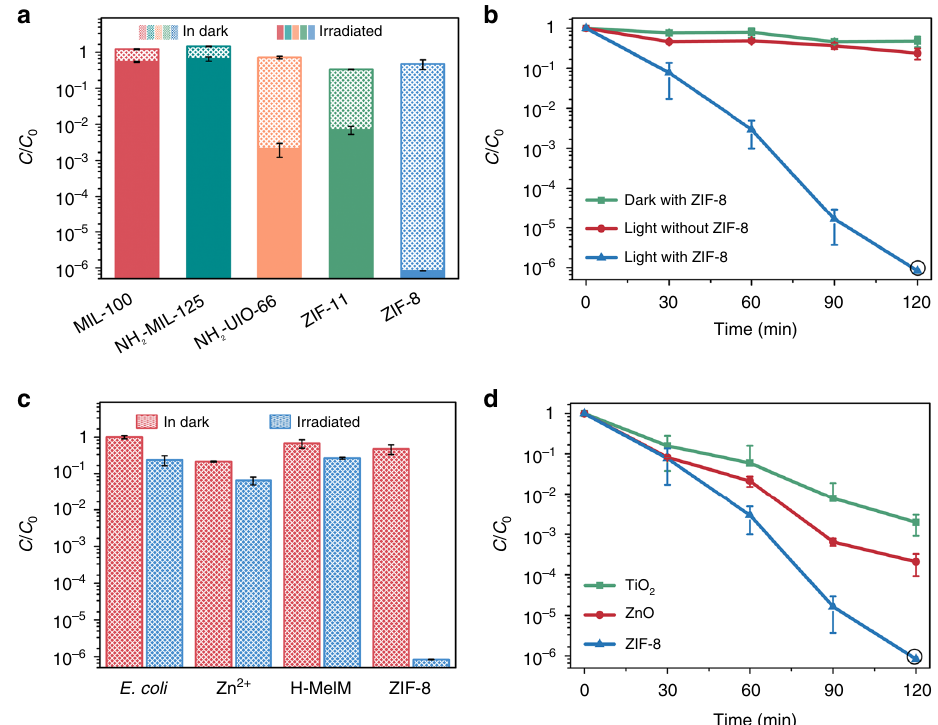
Fig. 2 Photocatalytic disinfection performance of ZIF-8 (zinc-imidazolate MOF). a Disinfection performance comparison among fi ve metal-organic frameworks (MOFs). b Inactivation kinetics of E. coli in the presence of ZIF-8. c Inactivation ef fi ciency against E. coli in the presence of Zn 2 + (3 mg L − 1 ), 2- methylimidazole (H-MeIM) (7 mg L − 1 ), and ZIF-8 (500 mg L − 1 ), respectively. d Disinfection performance comparison among ZIF-8, TiO 2 , and ZnO